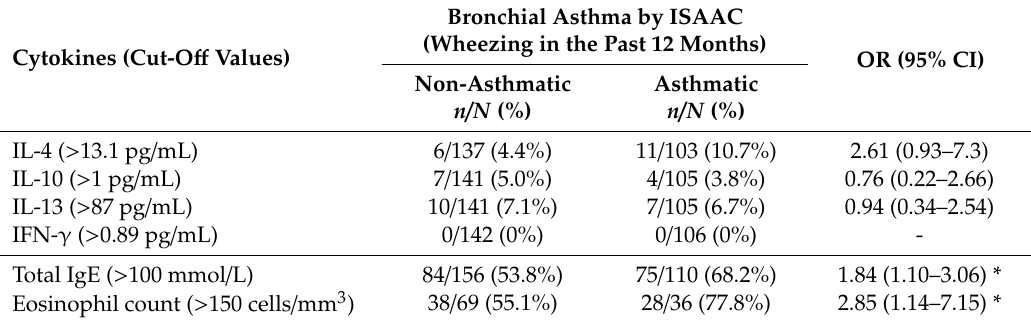
Table 1. The distribution of raised levels of cytokines, total immunoglobulin E (IgE), and eosinophil count among the study sample of adult asthmatics.